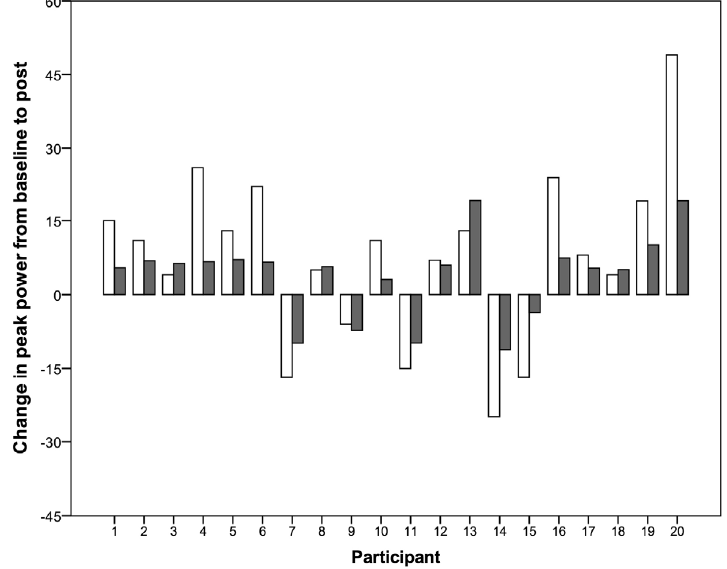
Figure 3. Individual changes in absolute (white bars in [W]) and relative (grey bars in [%]) of peak power from baseline to post measurement in the intervention study.